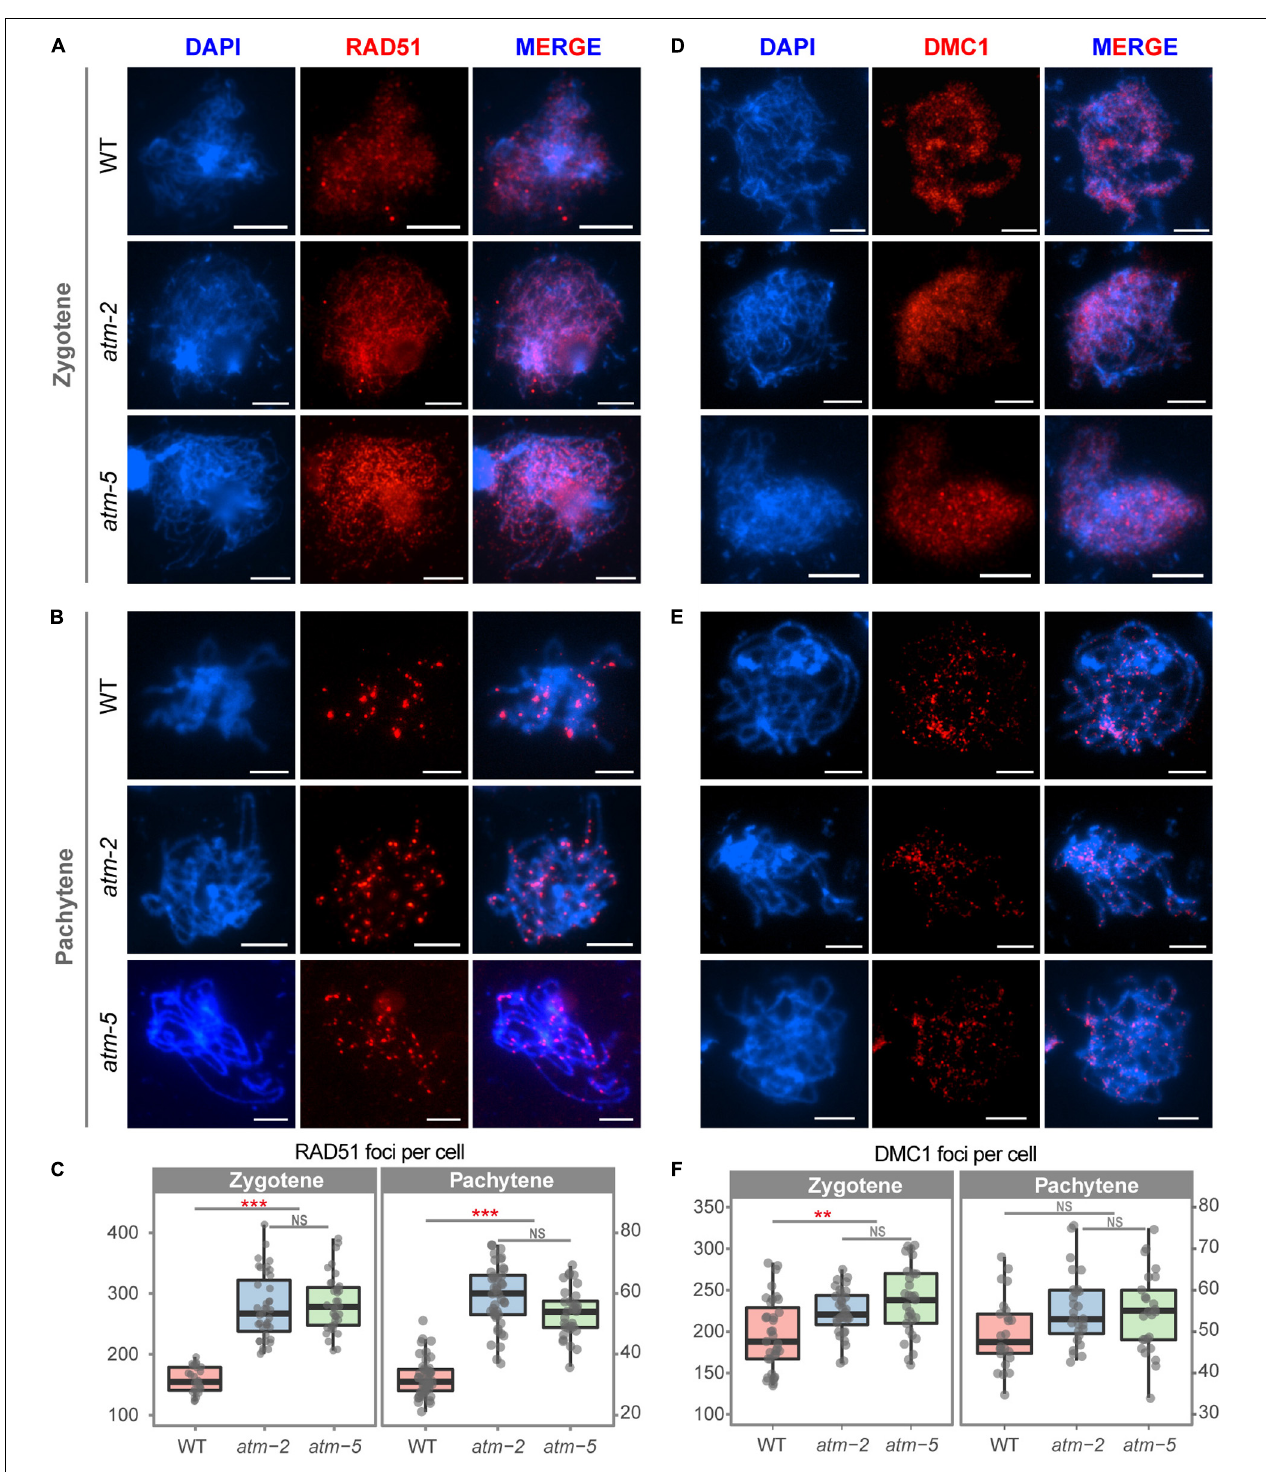
FIGURE 4 | Immunolocalization of RAD51 and DMC1 in male meiocytes of wild type and atm mutants. (A) RAD51 localization on zygotene stage chromosomes of wild type, atm-2 and atm-5 respectively. (B) RAD51 localization in pachytene stage chromosomes of wild type, atm-2 and atm-5 respectively. (C) Number of RAD51 foci per cell of zygotene (WT: 168 ± 21.09, n = 27; atm-2 : 279.15 ± 52.72, n = 40, P = 8.91E-12; atm-5 : 285.67 ± 45.57, n = 39, P = 1.55E-11) and pachytene (WT: 32.15 ± 6.14, n = 47; atm-2 : 58.84 ± 10.17, n = 43, P = 2.15E-15; atm-5 : 53.6 ± 8.6, n = 32, P = 5.55E-13) stage cells in different alleles. (D) DMC1 localization on zygotene stage chromosomes of wild type, atm-2 and atm-5 respectively. (E) DMC1 localization in pachytene stage chromosomes of wild type, atm-2